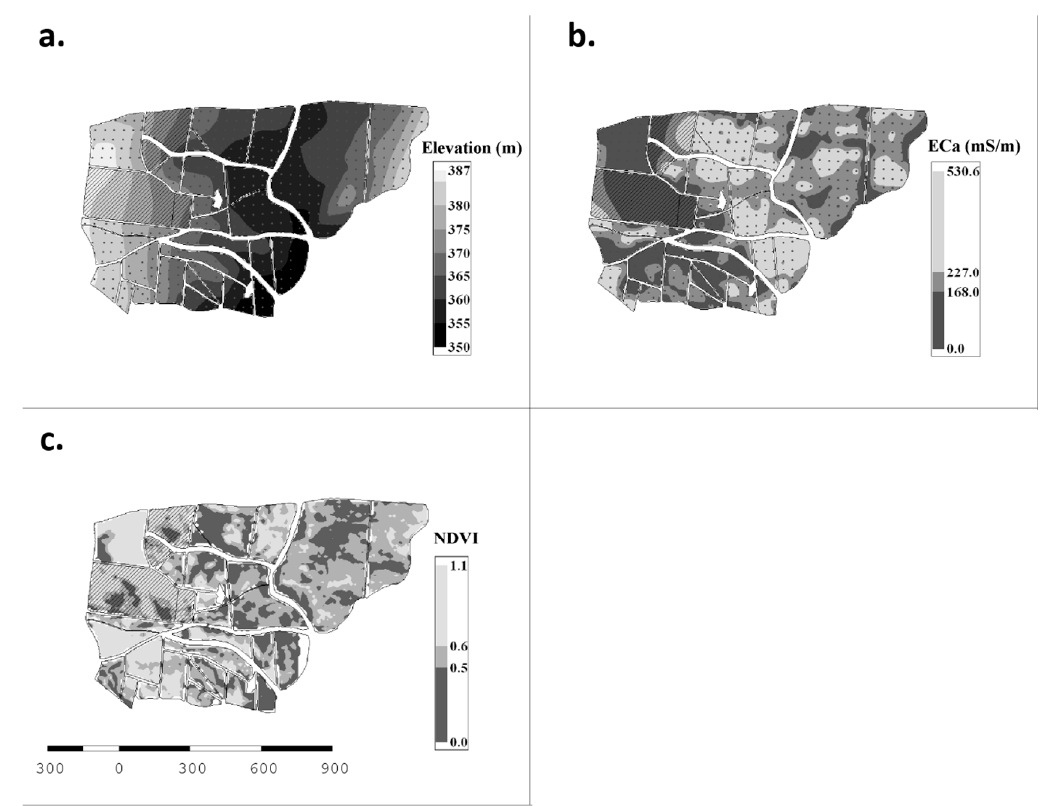
Figure 9. Maps of the whole-vineyard showing the spatial variability in ( a ) elevation; ( b ) soil apparent conductivity (EC a ); and ( c ) vegetative expression (normalized difference vegetation index (NDVI)). Points in ( a , b ) indicate sampling locations ( n = 256) (reproduced with permission from Reference 35) [35].